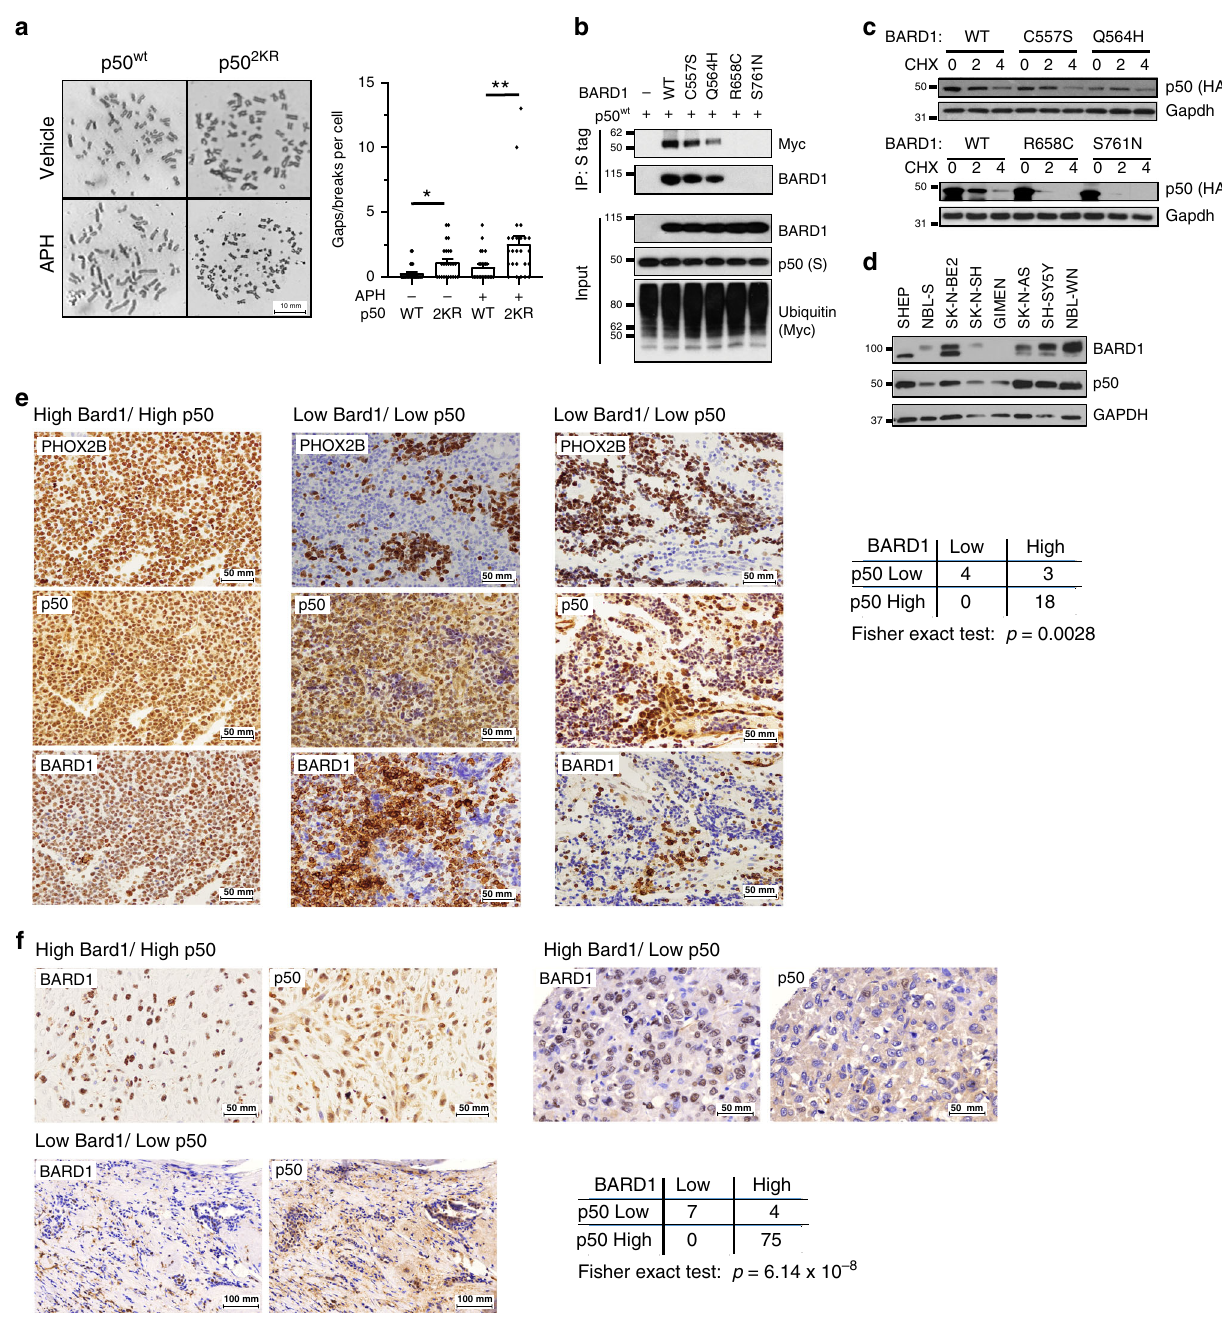
Fig. 7 BARD1 and p50 protein in human cancer. a Analysis of breaks and gaps in primary Nfkb1 -/- MEFs expressing either p50 wt or p50 2KR . Cells were treated with vehicle or aphidicolin (APH, 0.1 μ M 24 h). Data show gaps or breaks from 25 random metaphase cells, ± SEM. * P = 0.003, ** P = 0.007, two- sided unpaired Student ’ s t -test. Representative metaphase spreads shown (left). b Co-IP in Bard1 -null mouse cells transfected with Myc-Ub, S-tag p50 wt and either empty vector or BARD1 wild type or mutant as indicated. IP with S-agarose was performed on nuclear fractions and analyzed by IB with anti-Myc or anti-BARD1 antibody. c Bard1 -null mouse cells transfected with HA-p50 wt and the indicated BARD1 construct. Cells were treated with cycloheximide (CHX) and harvested at the indicated time. IB with anti-HA antibody. d Neuroblastoma cell lines analyzed by IB with anti-BARD1 (A300-263A) or anti-p50 antibody. e Representative IHC staining of p50 and FL BARD1 in neuroblastoma patient samples. Only regions with paired-like homeobox 2b (PHOX2B)- positive cells considered in p50/BARD1 scoring. Left — high BARD1/high p50, all cells are PHOX2B positive (brown) and have high nuclear p50 and BARD1. Center and right — low BARD1/low p50 from two independent patients, regions that are positive for PHOX2B (brown) have low (blue) nuclear p50 and low BARD1. Table shows numbers of tumors in each category analyzed by two-sided Fisher ’ s exact test. f Representative IHC staining of p50 and FL BARD1 in human breast cancer TMAs. Only nuclear p50 and BARD1 examined. Left upper — high BARD1/high p50; right upper — high BARD1/low p50, left lower — low BARD1/low p50. Table (right lower) shows numbers of tumors in each category analyzed by two-sided Fisher ’ s exact test. All blots are representative of at least two biologically independent